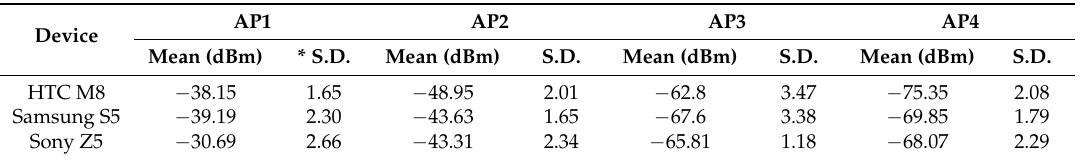
Table 1. Mean received signal strength indicator (RSSI) values and standard deviations for three smartphones used to collect Wi-Fi signals from 4 access points (APs) for 60 s.